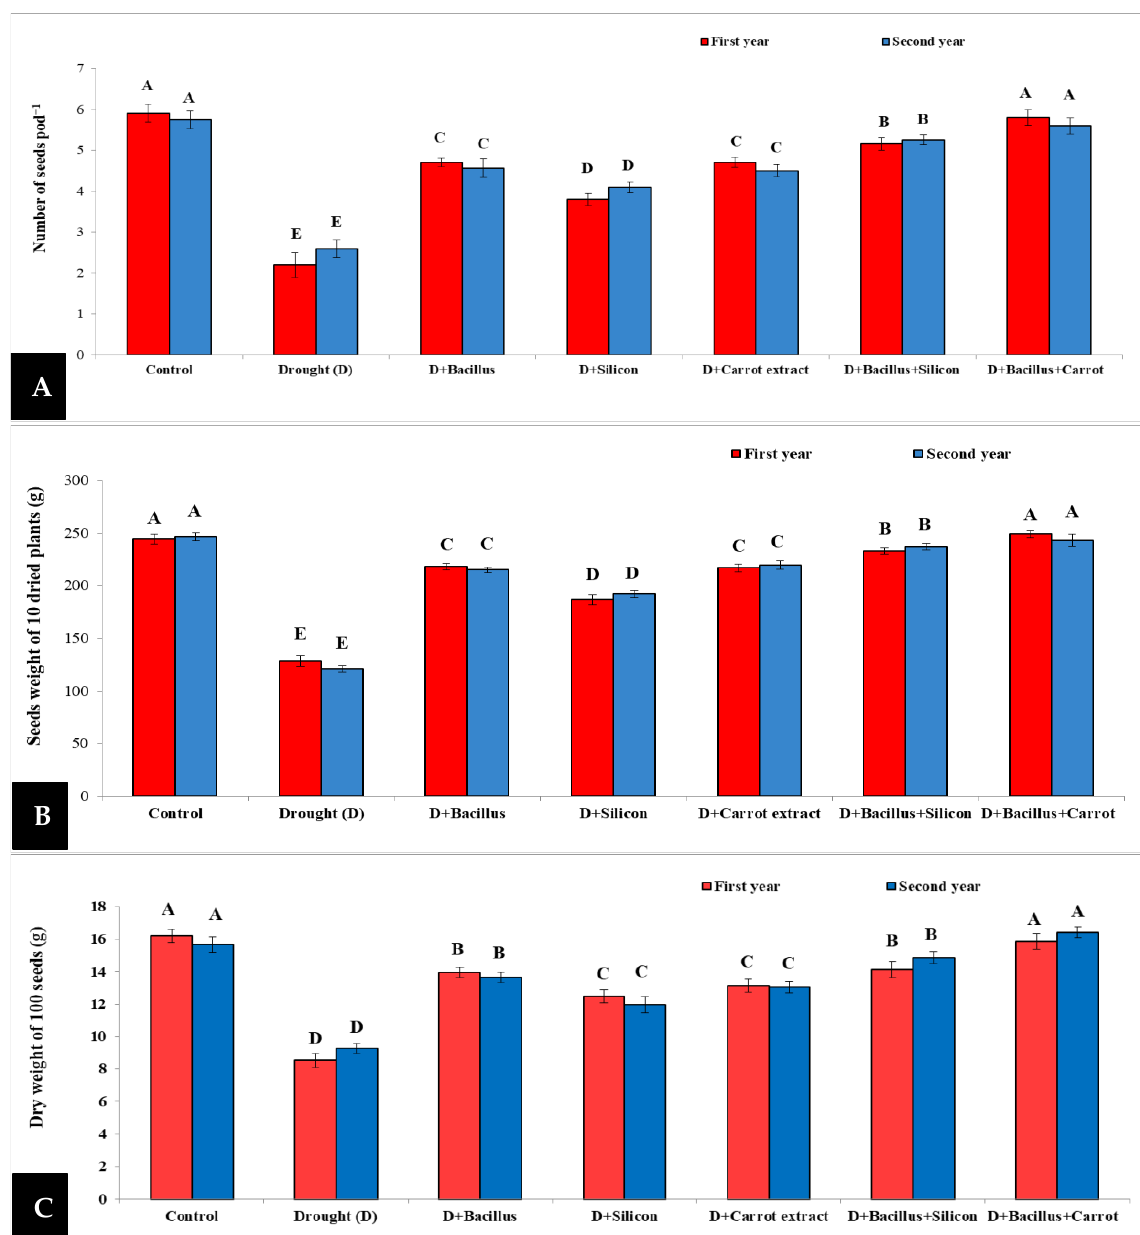
Figure 3. Effect of Bacillus thuringiensis , silicon and carrot extract on number of seeds pod −1 ( A ), seeds weight of 10 dried plants ( B ), and dry weight of 100 seeds ( C ) of drought-stressed pea plants during 2019/2020 and 2020/2021 seasons. Different letters on the columns show significant differences between the treatments according to ANOVA, and Duncan’s post hoc test when the result of the omnibus multivariate F-test in ANOVA was significant ( p ≤ 0.05). Data is the mean (± SE) of five replicates.